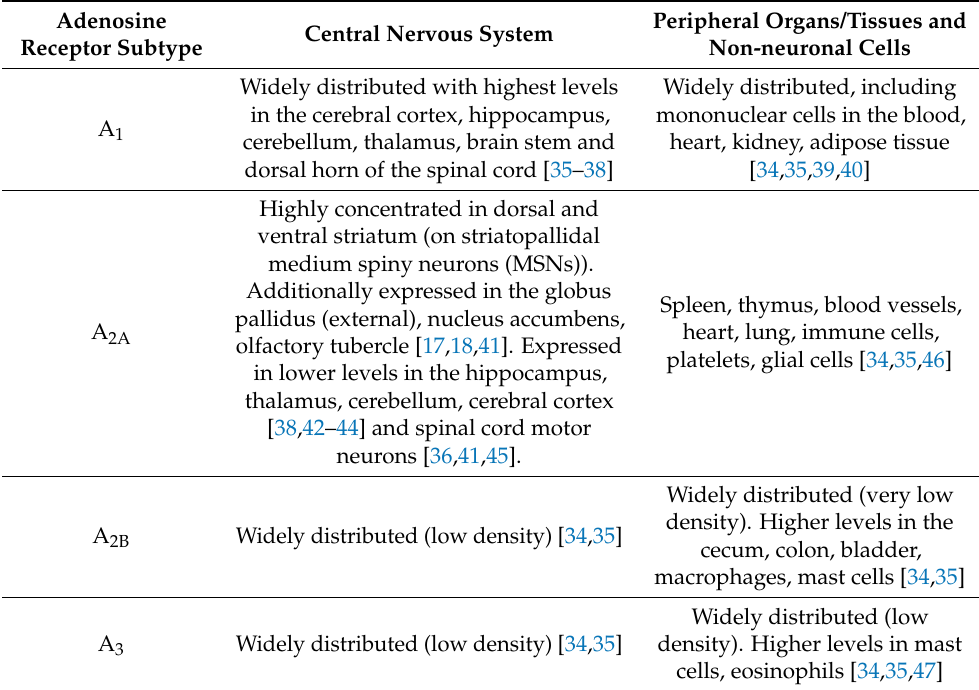
Table 1. Adenosine receptor